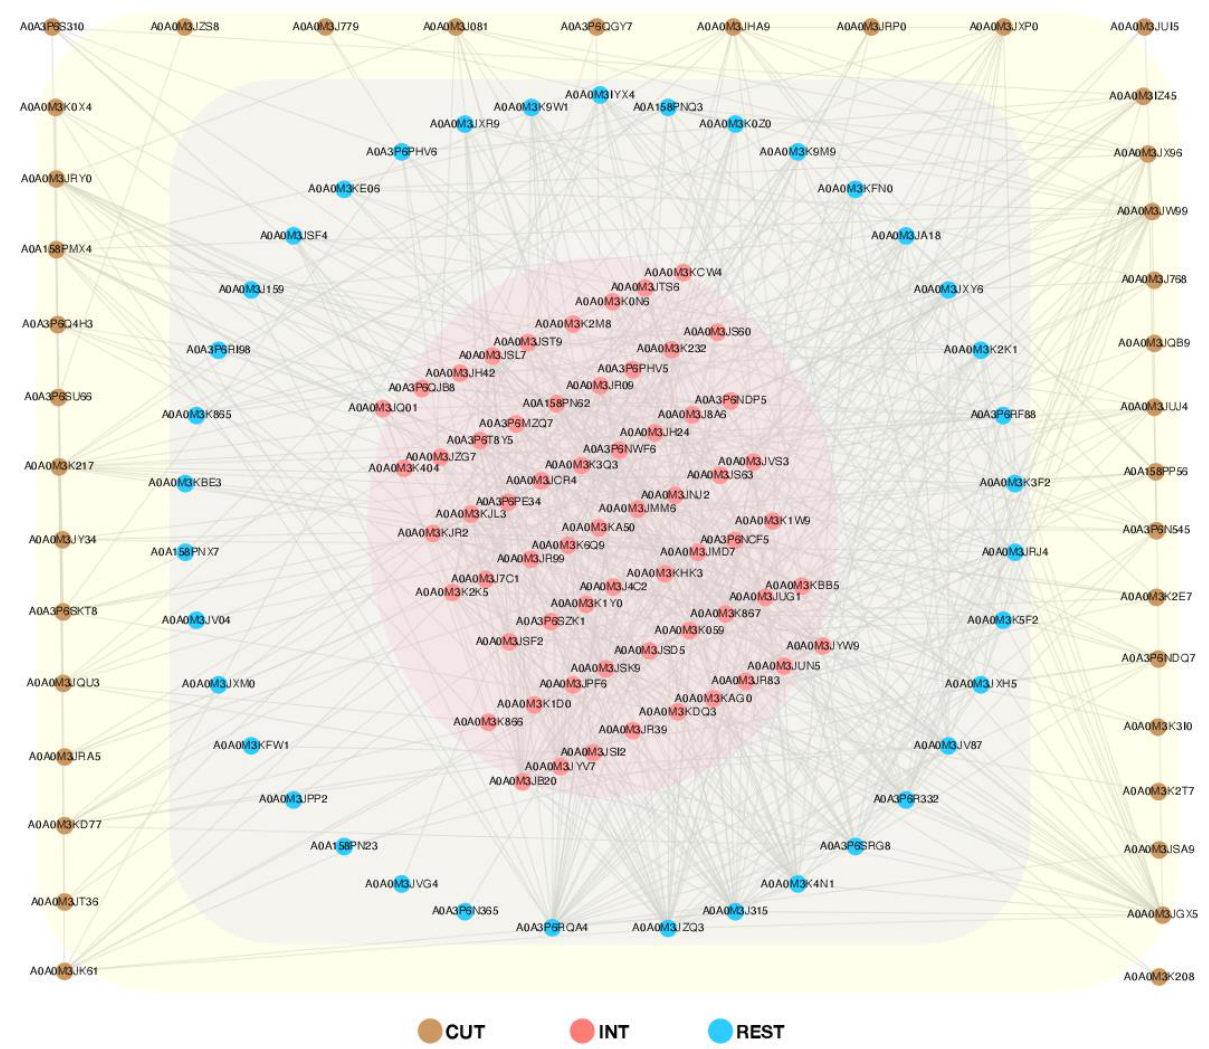
Figure 6. Protein–protein interaction network analysis of differentially regulated proteins between the cuticle, intestine, and rest of the body of the L4 development stage of Anisakis simplex s. s. Visualization was performed in Cytoscape v. 3.9.1. A detailed description of all proteins submitted to the analysis can be found in File